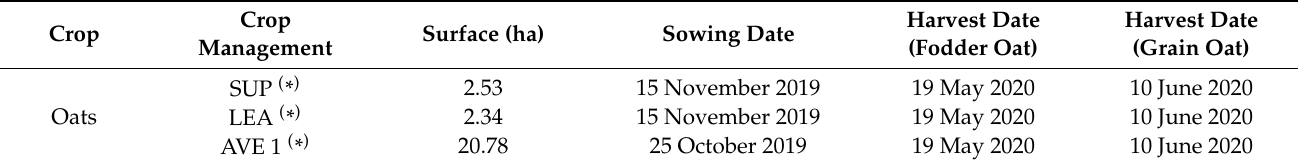
Table 1. Oats and garlic monitored